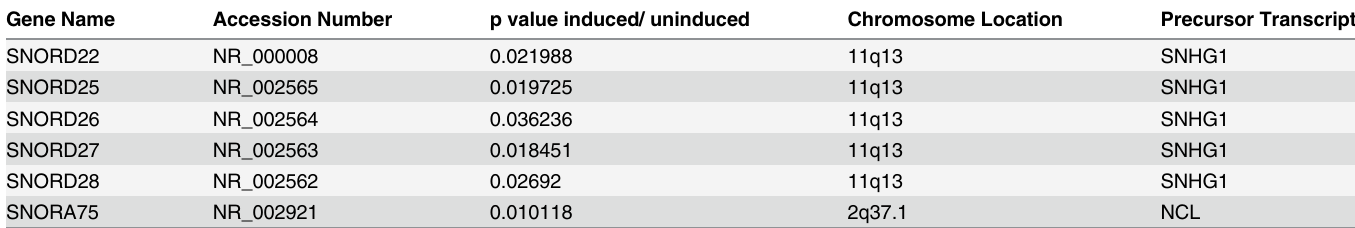
Table 1. snoRNAs repressed by p53 in H1299 and WE-68